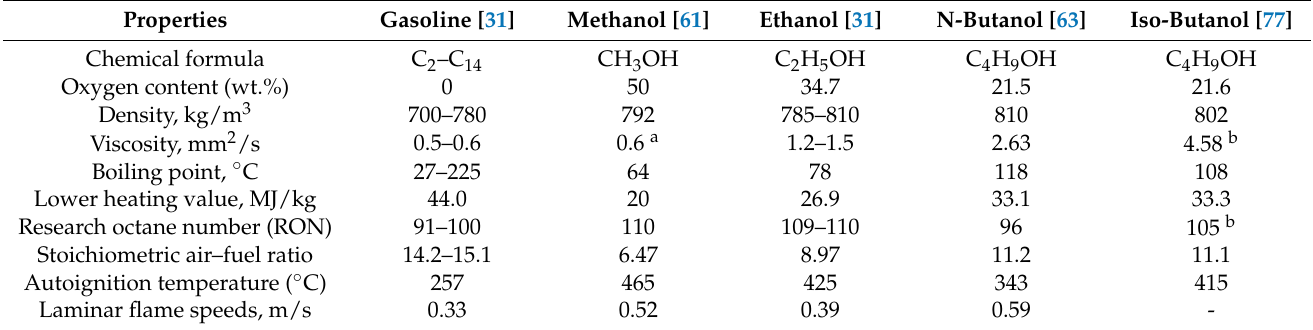
Table 1. Properties of alcohol-based alternative fuels and gasoline